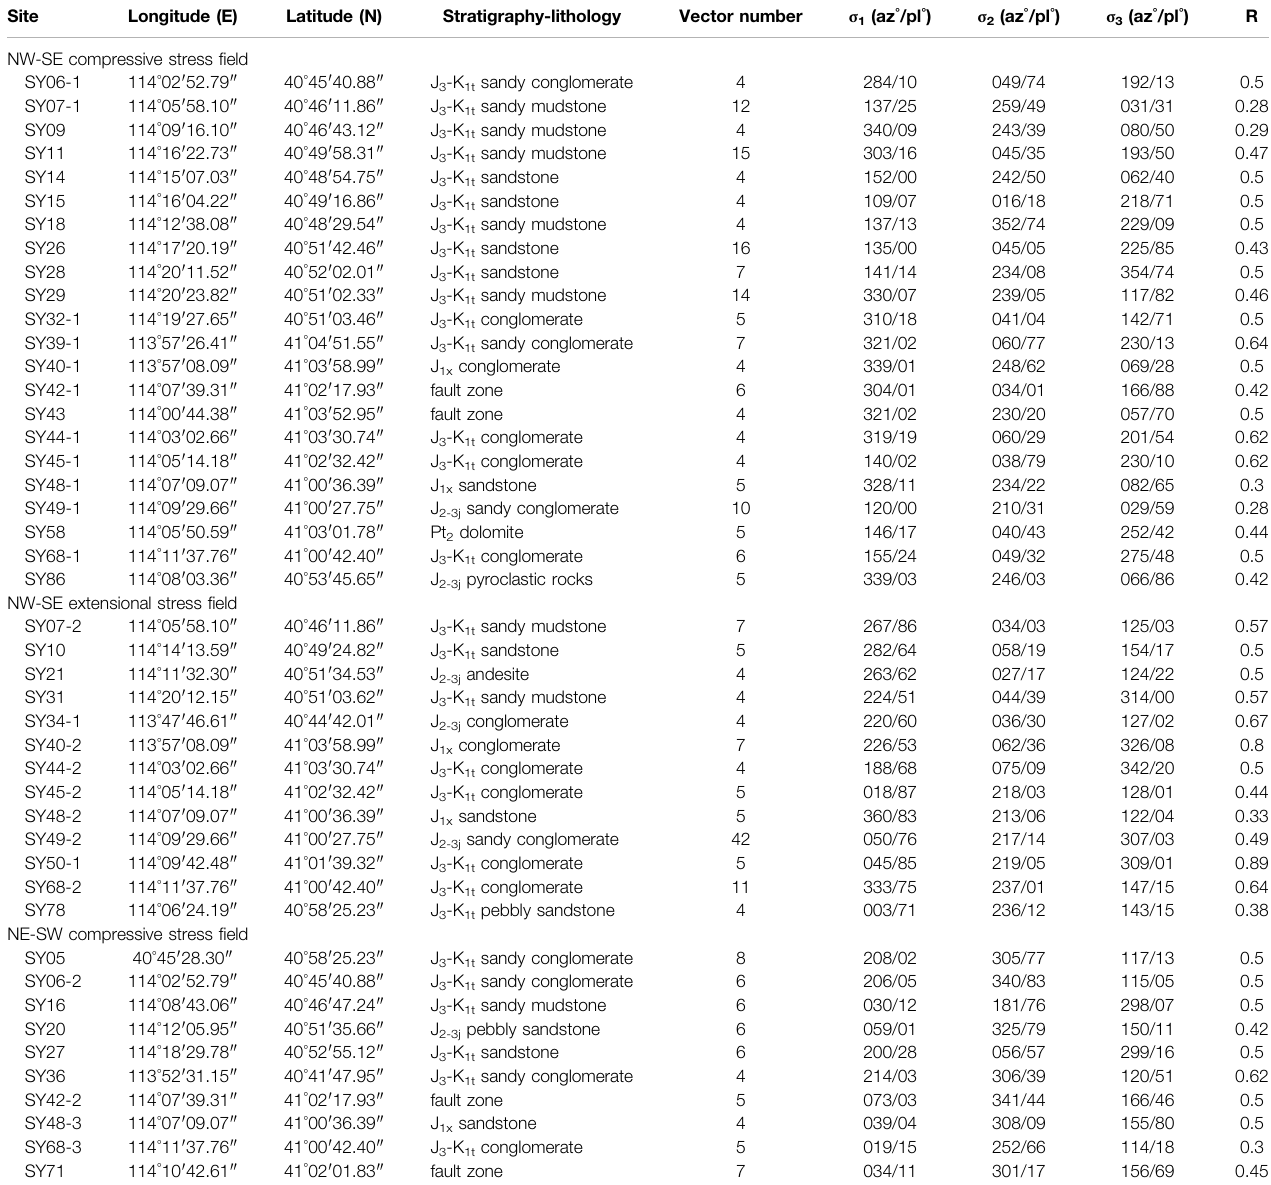
TABLE 1 | Slip vectors on fault planes measured in the Shangyi Basin and their paleostress fi elds. Site Longitude (E) Latitude (N)